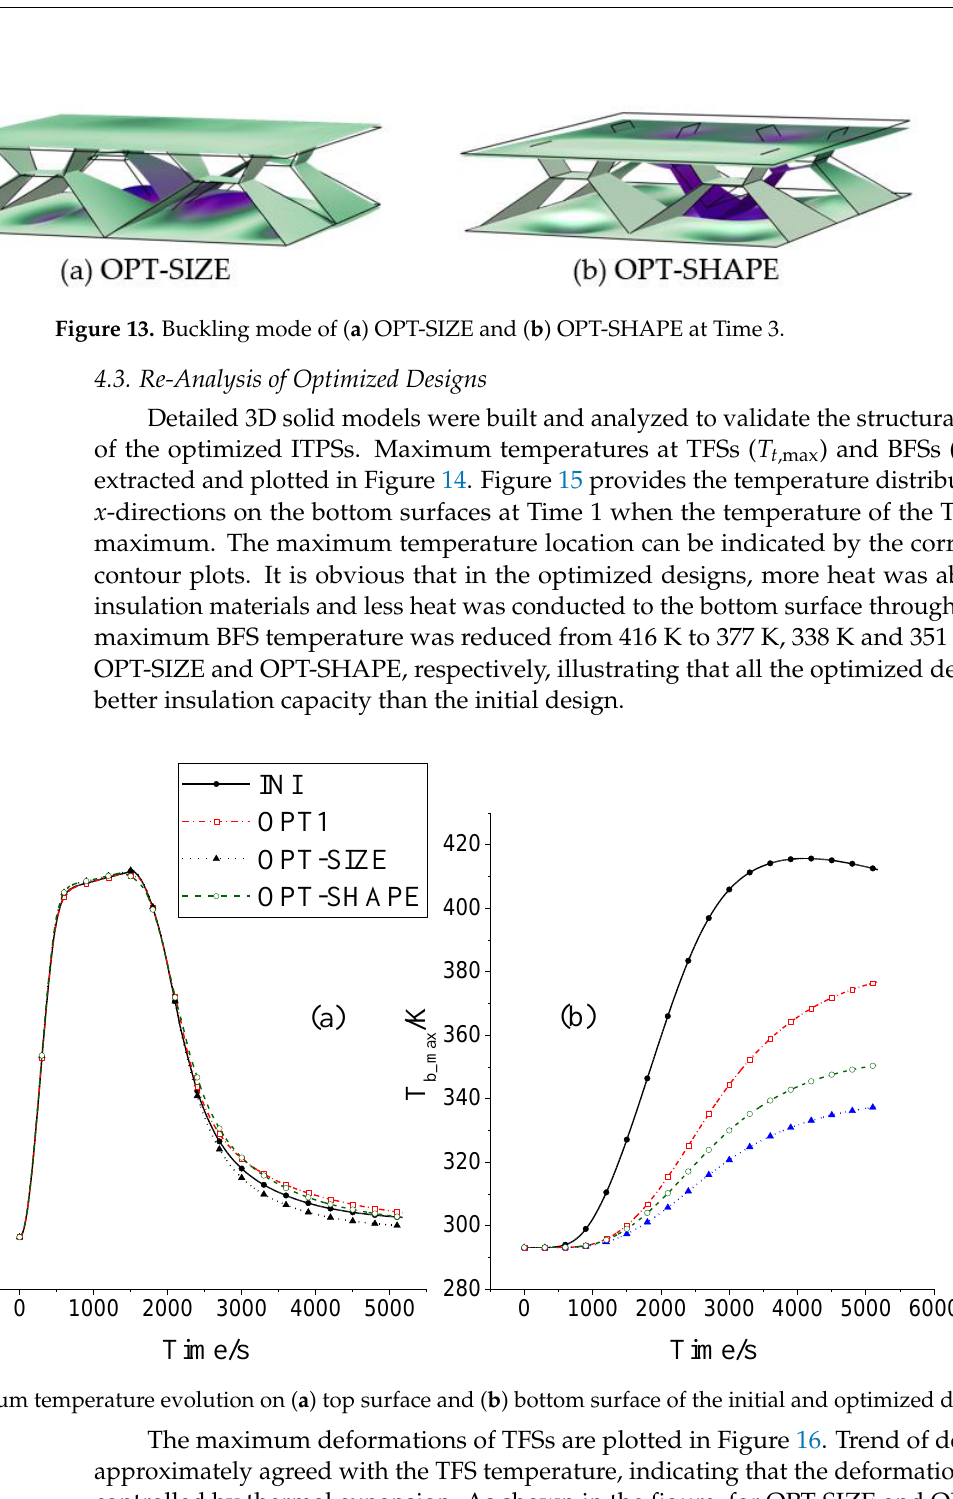
Figure 15. ( a ) Temperature along the path on bottom surface. ( b ) INI, ( c ) OPT1, ( d ) OPT-SIZE and ( e ) OPT-SHAPE. The paths are marked by arrow lines. The maximum deformations of TFSs are plotted in Figure 16. Trend of deformation approximately agreed with the TFS temperature, indicating that the deformation is mainly controlled by thermal expansion. As shown in the figure, for OPT-SIZE and OPT- SHAPE, the maximum deformation of the TFS was slightly increased by 0.16 mm and 1.2 mm, respectively, which is acceptable considering the overall height of the ITPS. Corre- spondingly, the maximum thermal stress was reduced from 1.08 GPa to 446.4 MPa and 420.1 MPa, respectively, indicating fewer thermal expansion effects in optimized designs.